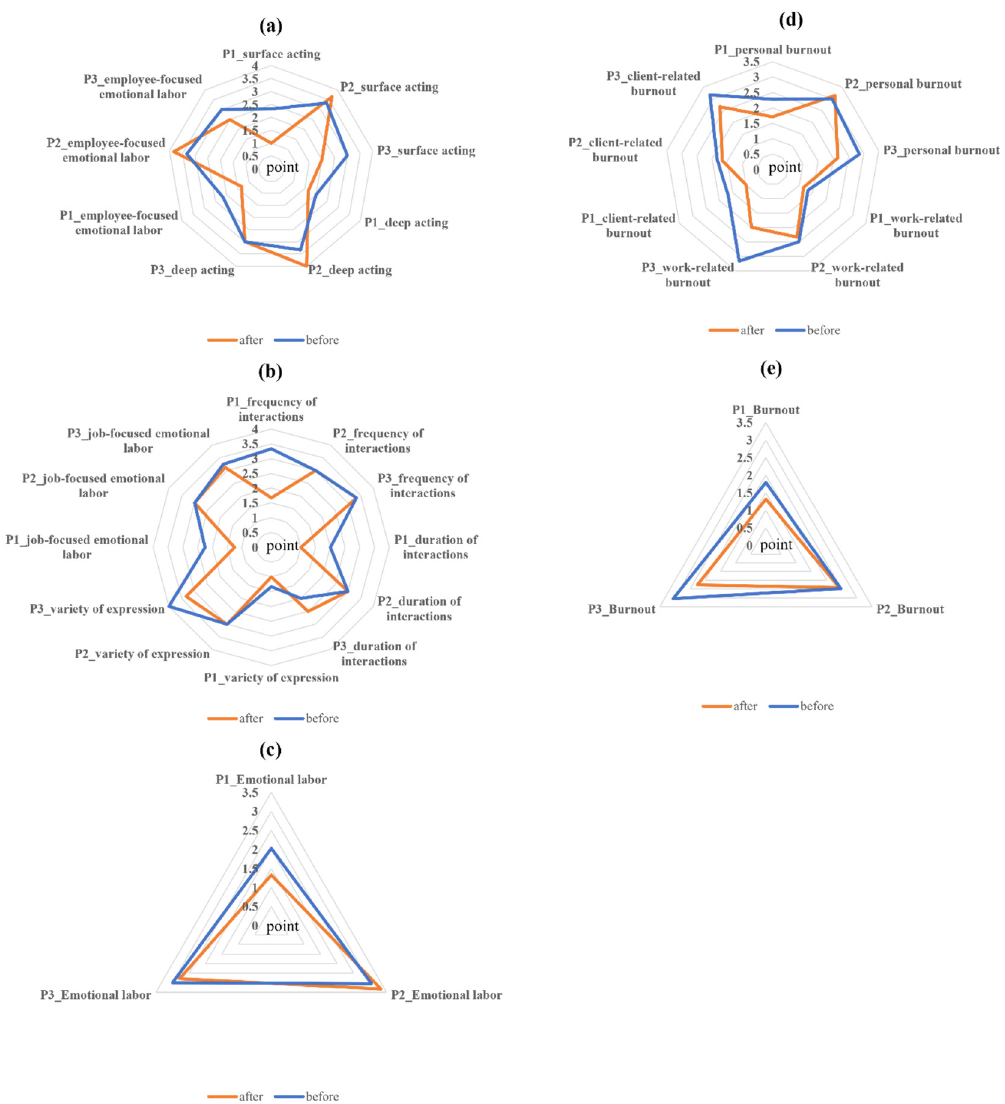
Figure 2. Pre-and-post evaluation of the participants. ( a ) Employee-focused emotional labor, ( b ) job- focused emotional labor, ( c ) total emotional labor, ( d ) subscales of burnout, and ( e ) total burnout in participants before and after the mindfulness program. P = participant.